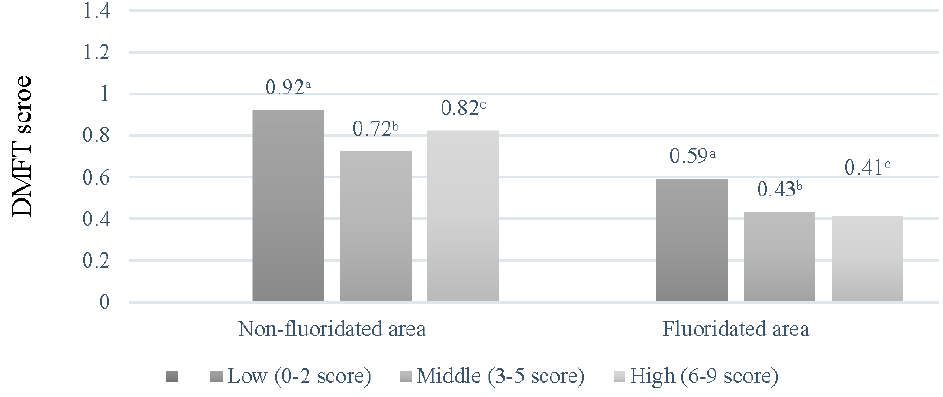
Figure 3. Distribution of decayed, missing, and filled teeth (DMFT) scores based on the Family Affluence Scale scores. The scores were calculated from the univariate analysis of variance: a Covariates appearing in the model are evaluated at the following values: age = 8.53; b Covariates appearing in the model are evaluated at the following values: age = 8.56; c Covariates appearing in the model are evaluated at the following values: age = 8.63.